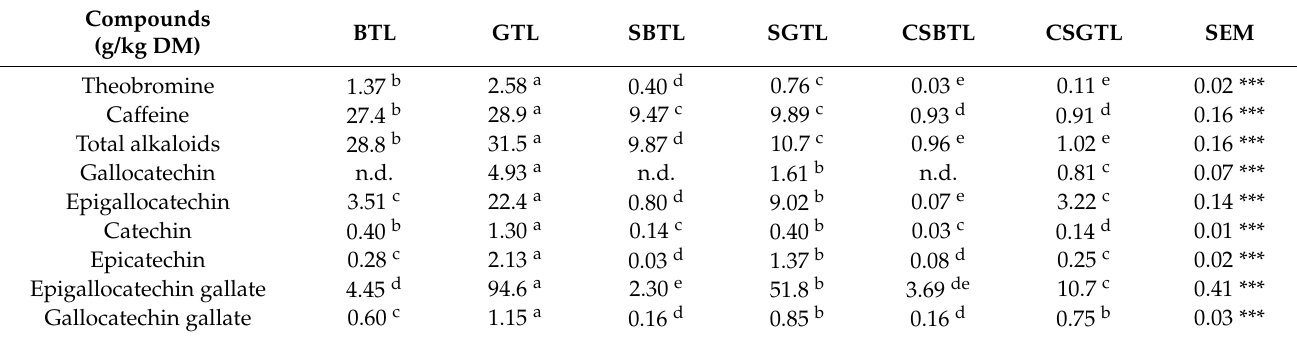
Figure 2. Example HPLC chromatograms of GTL ( left ) vs. SGTL ( right ) samples: (1) Theobromine, (2) gallocatechin, (3) epigallocatechin, (4) catechin, (5) Caffeine, (6) epicatechin, (7) epigallocatechin gallate, (8) gallocatechin gallate, (9) epicatechin gallate, (10) catechin gallate, (11) Rutin, (12) theaflavin, (13) theaflavin-3-gallate, (14) theaflavin-3 (cid:48) -gallate, and (15) theaflavin-3,3 (cid:48) -digallate. Table 4. Mean ( n = 3) alkaloid and phenolic components (g/kg DM) of different tea leaf products with SEM and